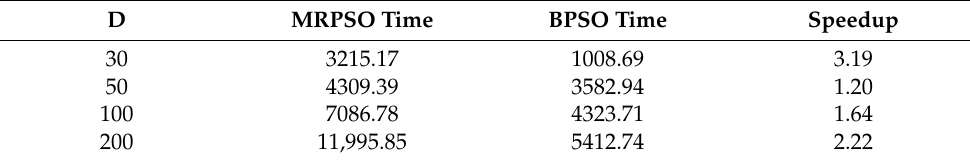
Table 13. MRPSO and BPSO running time and speedup on f 4 .